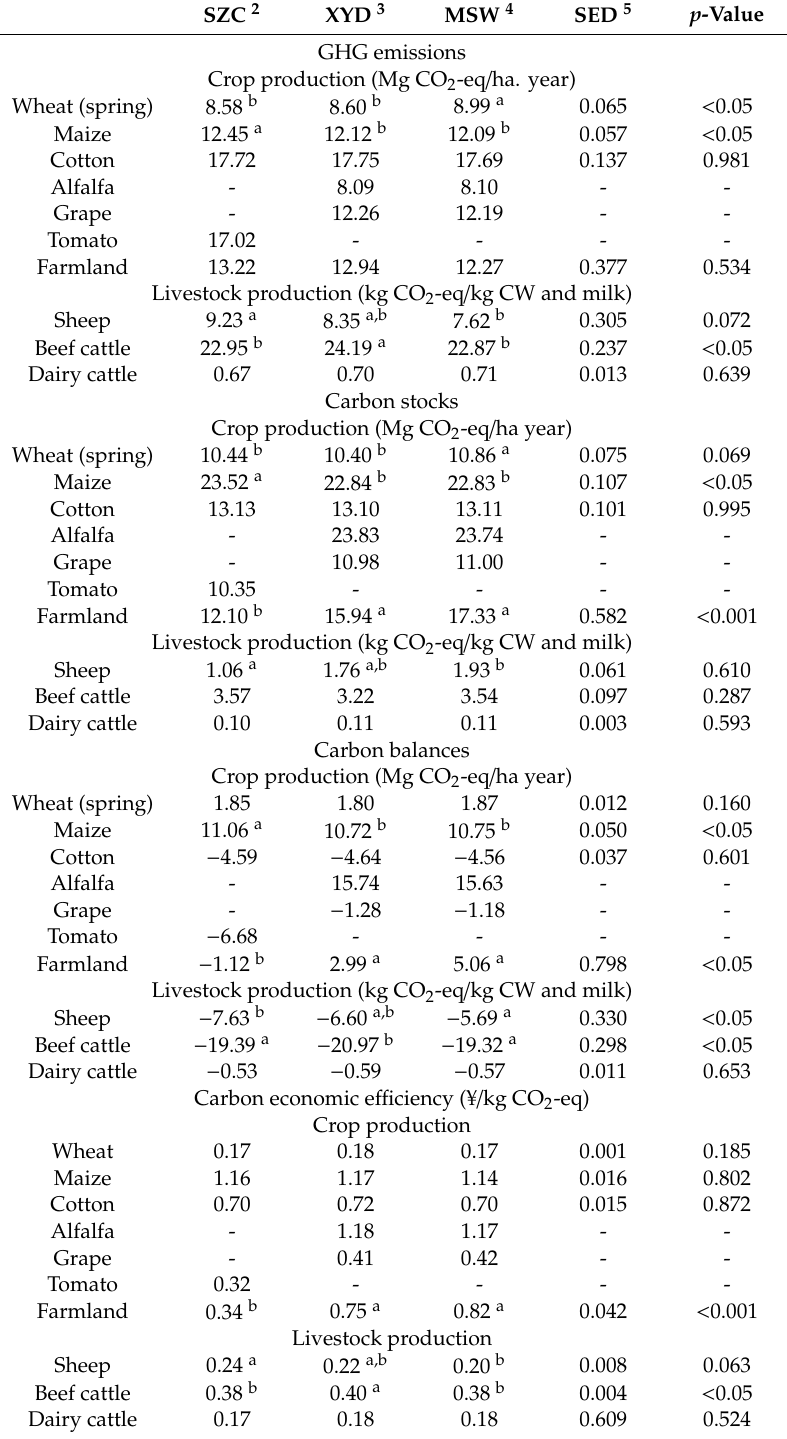
Table 5. GHG emissions, carbon stocks, carbon balances, and the carbon economic e ffi ciency of agricultural production in the Shihezi